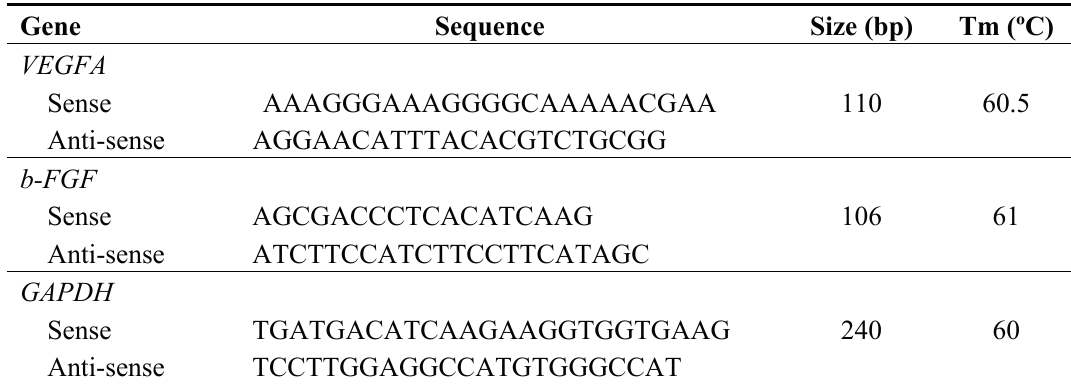
Table 1. qRT-PCR primer